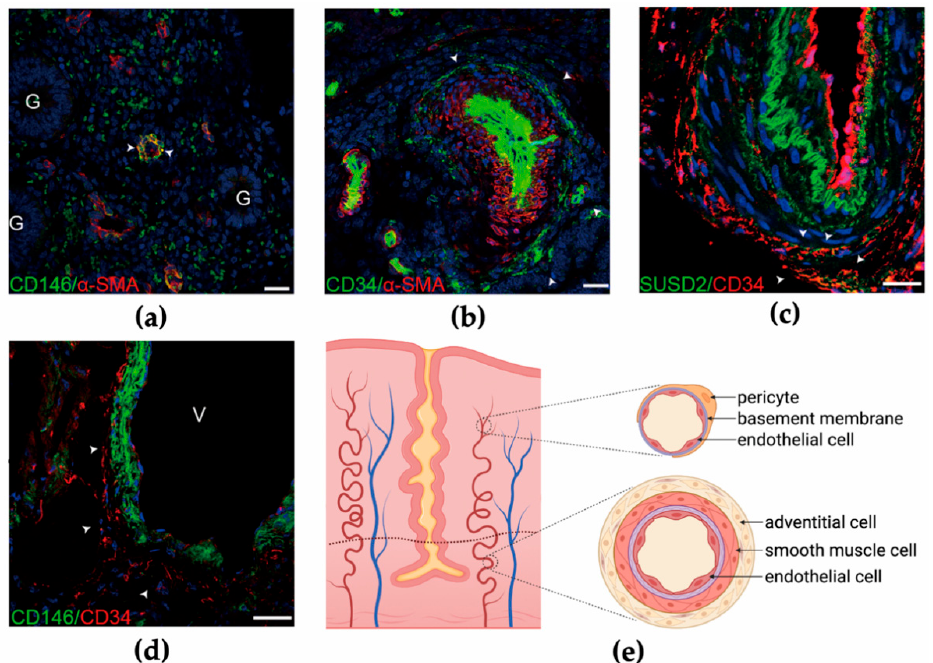
Figure 2. Perivascular cells in the human endometrium. ( a ) Co-staining of CD146 (green) and α -SMA (red) in human endometrial functionalis. G, glandular epithelial cell. ( b ) Cells expressing α -SMA in the tunica media are surrounded by CD34 + adventitial cells in human endometrial basalis. ( c ) Part of the CD34 + adventitial cells are co-stained with SUSD2. ( d ) CD34 + adventitial cells enclose CD146 + pericytes in large vessels in the human endometrium. V, vessel. ( e ) Schematic showing two groups of perivascular cells in the endometrium. Pericytes surrounding endothelial cells are located in microvessels in both functionalis and basalis, while adventitial cells reside in the outermost layer of large vessels, mainly in endometrial basalis. Figure 2a–d from Zhu, X., Yu, F., Yan, G., Hu, Y., Sun, H., and Ding, L. Human endometrial perivascular stem cells exhibit a limited potential to regenerate endometrium after xenotransplantation. Hum. Reprod. 2020